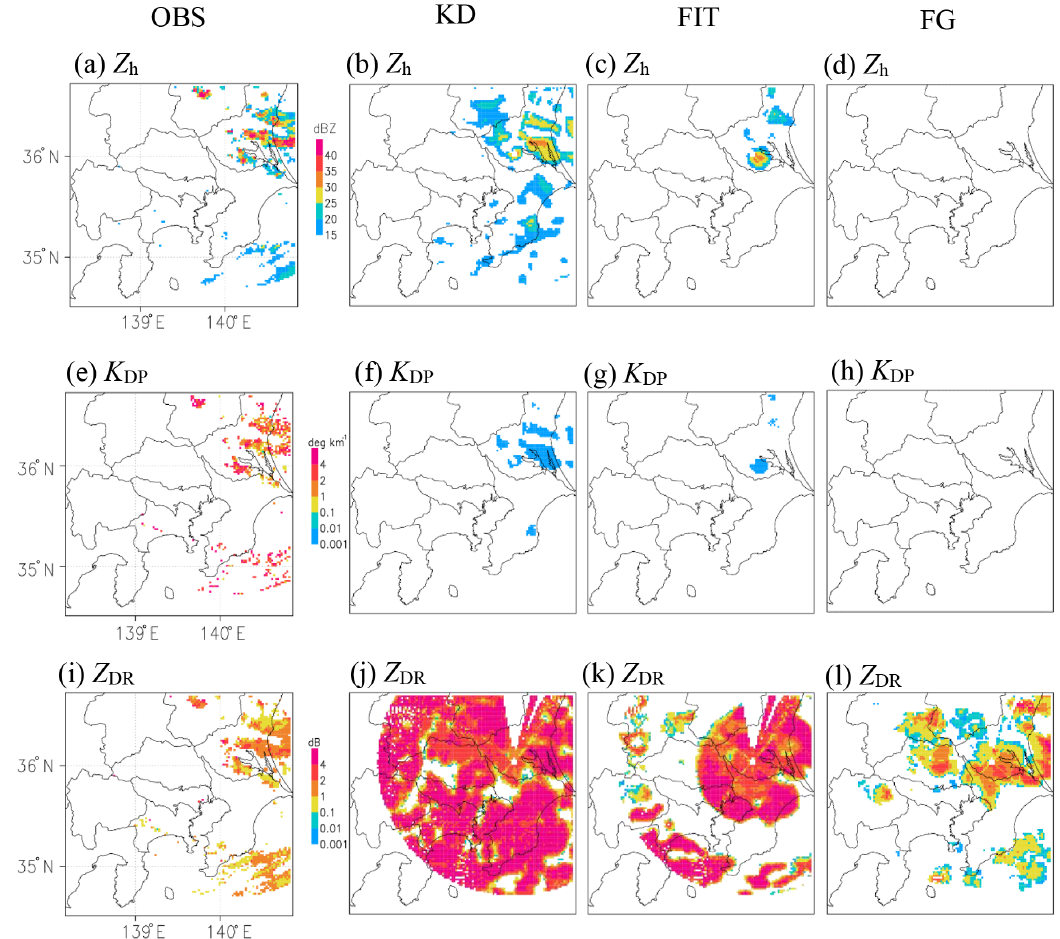
Figure 2. From left to right, horizontal distributions of polarimetric parameters of observations (OBS), assimilation results by KD and FIT with NHM-4DVAR, and the first-guess field (FG) at 21:04UTC on 23 June 2014. (a–d) Z h ; (e–h) K DP ; (i–l) Z DR .